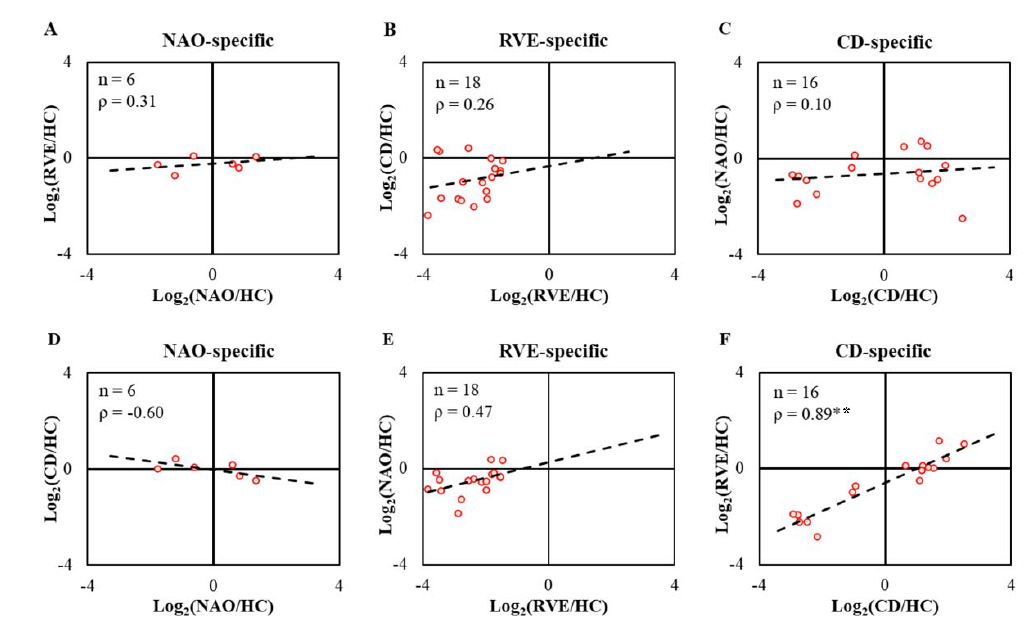
Figure 5. Spearman rank correlation analysis in between significantly altered proteins specific to three LACI groups (NAO, RVE, and CD). ( A , D ) Log ratios of proteins altered only in NAO compared to HC (NAO-specific, n = 6, x-axis) were correlated with RVE (RVE/HC) and CD (CD/HC) groups. A similar analysis was performed for proteins changed in RVE (RVE-specific, n = 18, ( B , E )) and CD (CD-specific, n = 16, ( C , F )) groups. A linear trendline was added for easy visualization of the comparative pattern of regulation. ρ , Spearman rank correlation; ** p < 0.01 (two ‐ tailed).